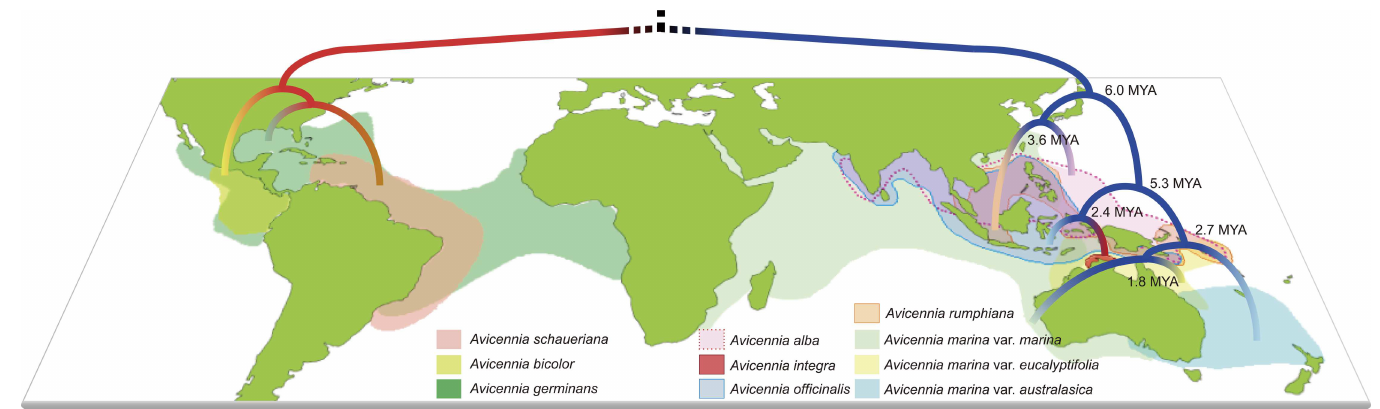
Fig 1. Distribution and the phylogenetics of Avicennia . Distributions of species are color coded on the map (modified from [34]). The map was modified from the 1:110m coastlinemap of Natural Earth (http://www.naturalearthdata.com). The phylogenetic relationshipbetween species is based on the phylogenicanalyses from chloroplast and nuclear genes. The divergencetime for species in the Indo-Western Pacific (IWP) region was calibratedby mcmctree 4 . 8a